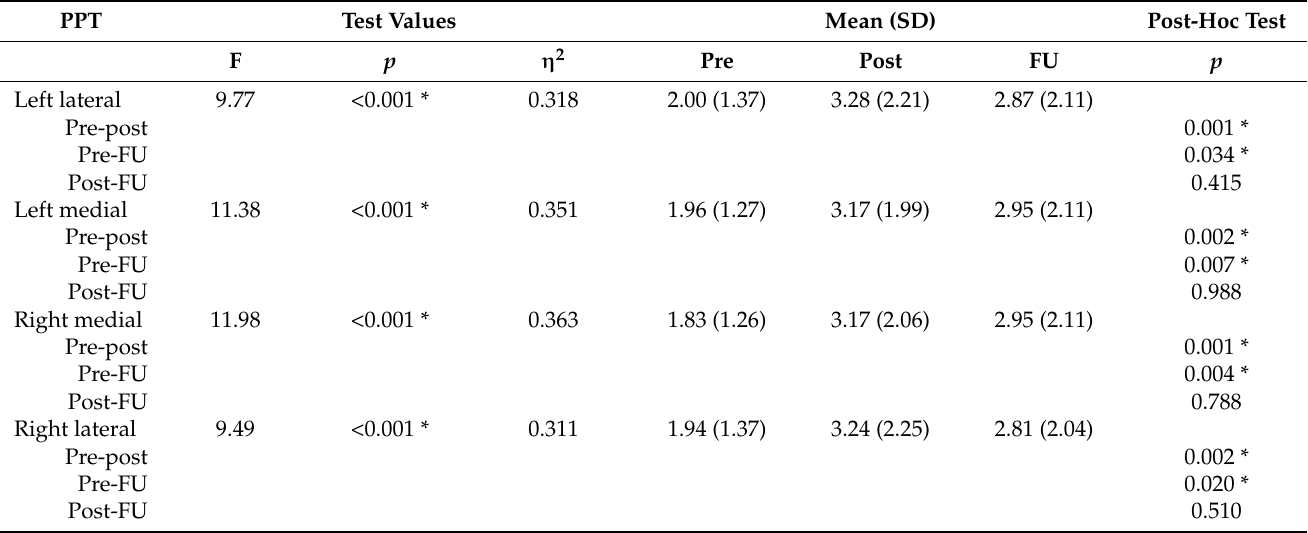
Table 2. Comparison of PPT above each reference point before the first rNMS session (pre), before the last rNMS session (post), and at FU.